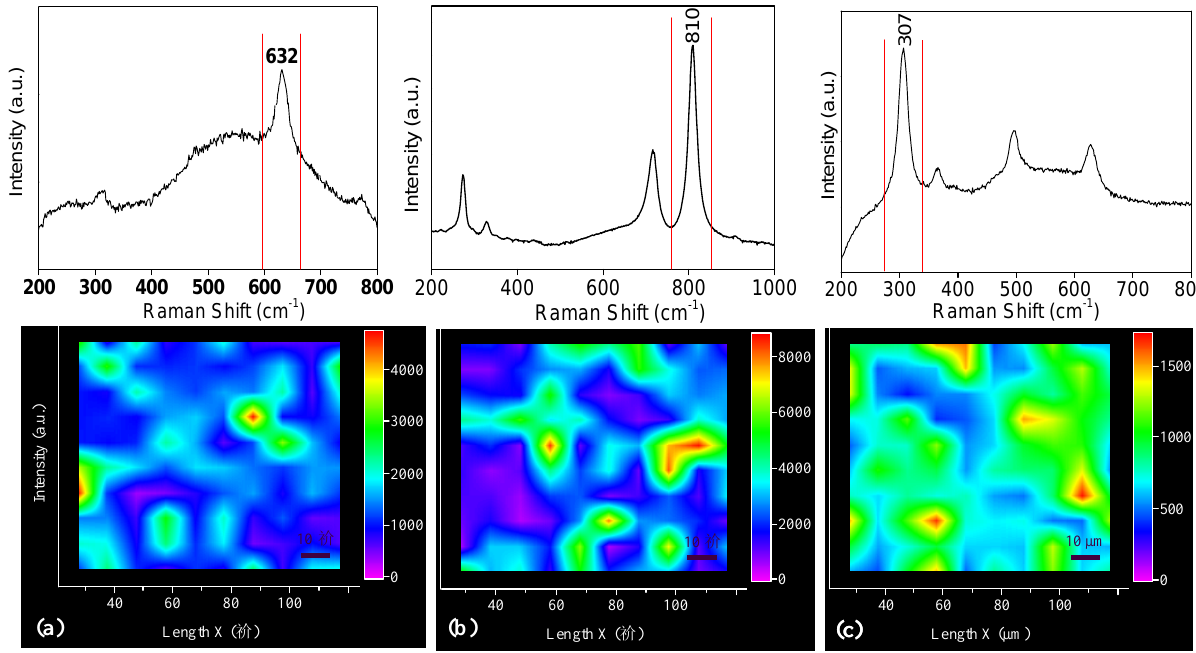
(b) WO and (c) In O 2 3 2 3